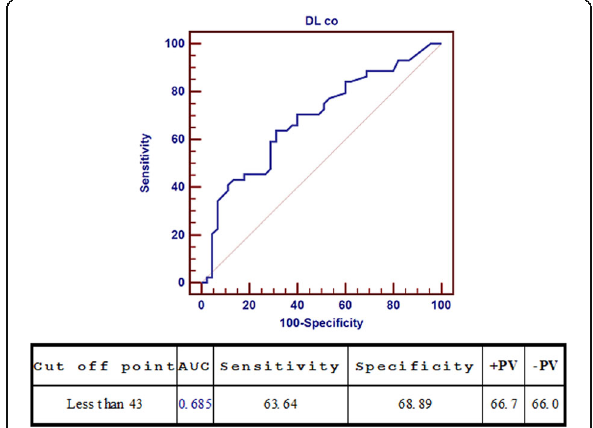
Fig. 3 ROC curve and coordinates for the best cutoff DLCO-SB value to predict honeycombing. ROC, receiver operating characteristic; AUC, area under the